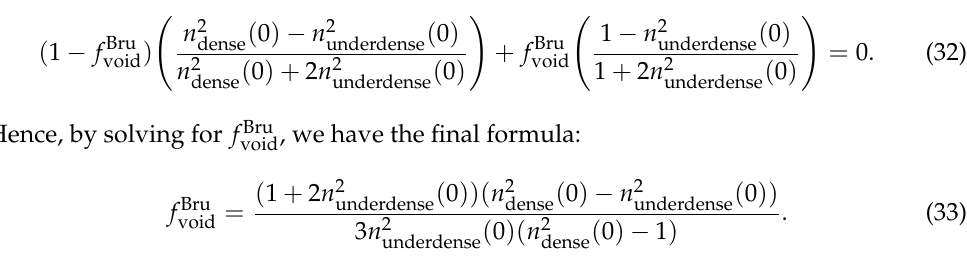
specific value of the photon energy of nearly 5.0 eV is 1.42 × 10 6 cm − 1 (see Figure